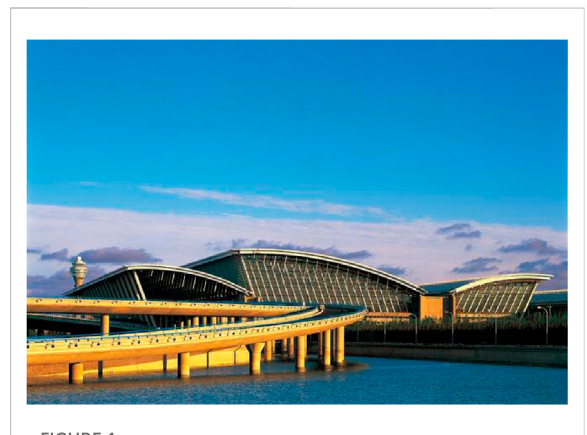
FIGURE 1 T1 terminal for Shanghai Pudong International